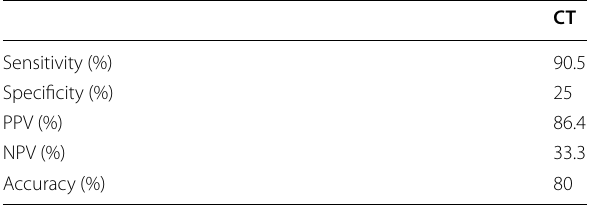
Table 6 Performance characteristics of CT in relation to